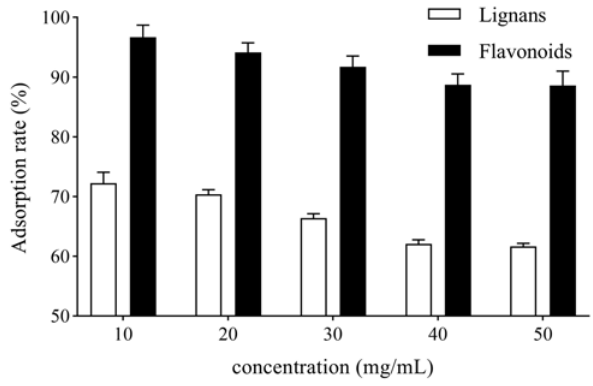
Figure 2. Effect of sample loading concentration of V. amurensis extract on the adsorption